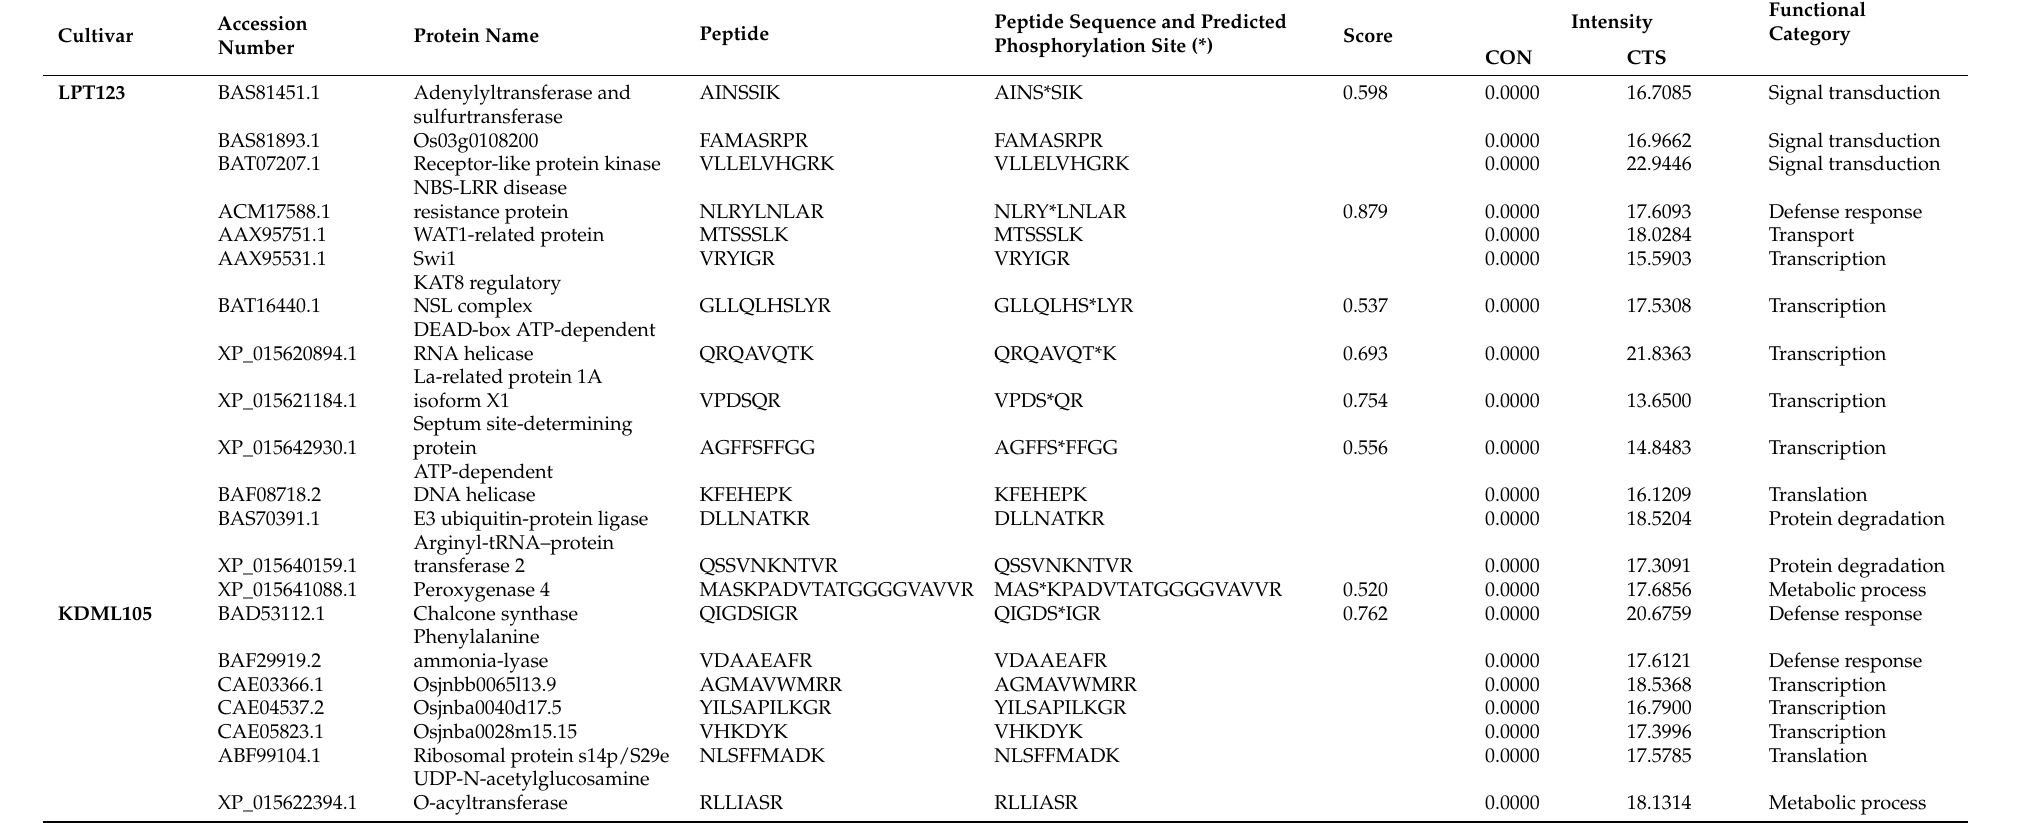
Table 1. The increased DEPs in both rice cultivars in response to CTS induction without osmotic stress